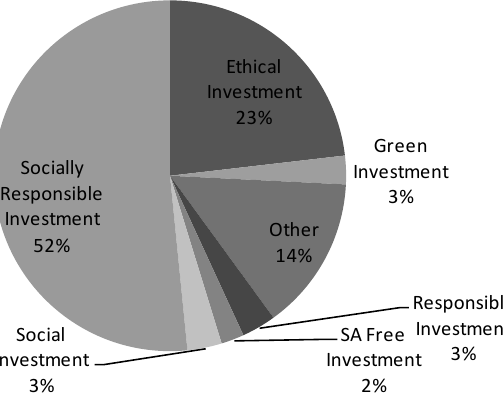
Figure 2: The appearance and frequency of names for investment practices that in some way integrate a consideration of ESG issues